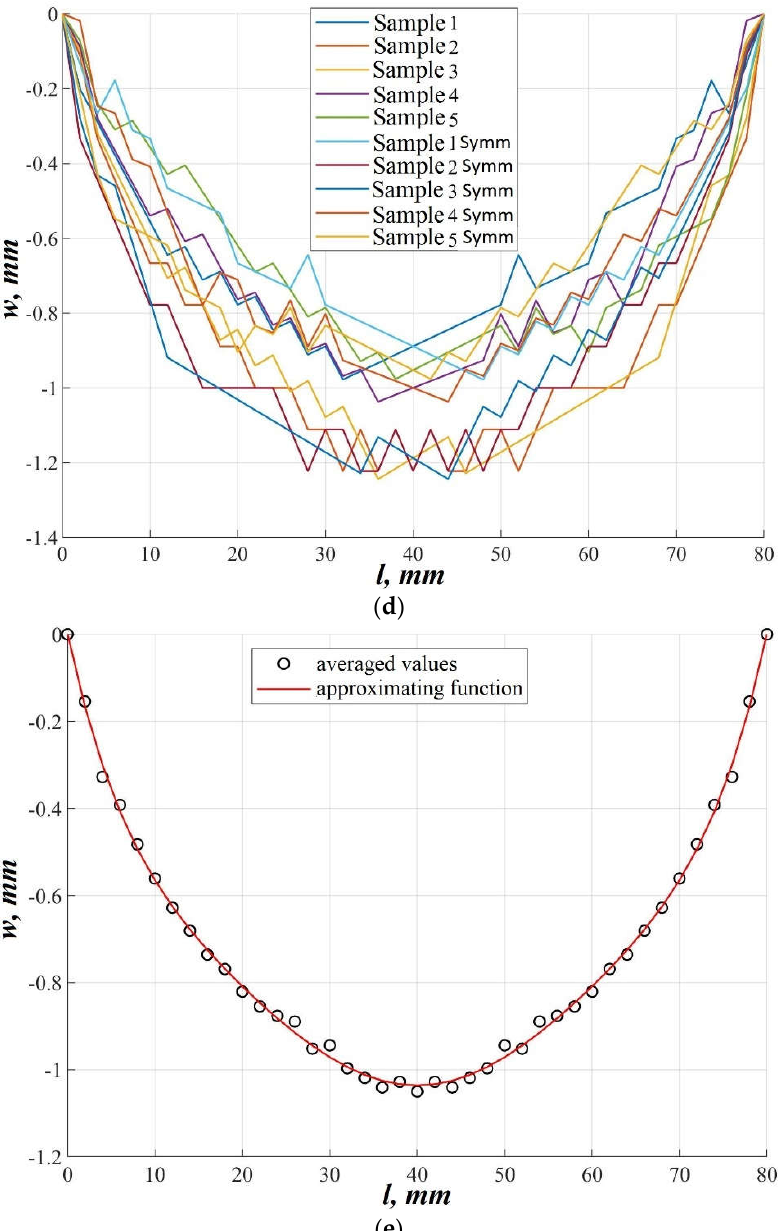
Figure 15. Processing the experimental results: ( a ) digitizing the bending; ( b ) plotting graphs based on the data obtained; ( c ) aligning the curves with respect to the extreme points; ( d ) converting curves to symmetrical; ( e ) averaging the values at coinciding points with subsequent approximation. The graphs show the value of the deflection (w) along the length (l) of the sample.